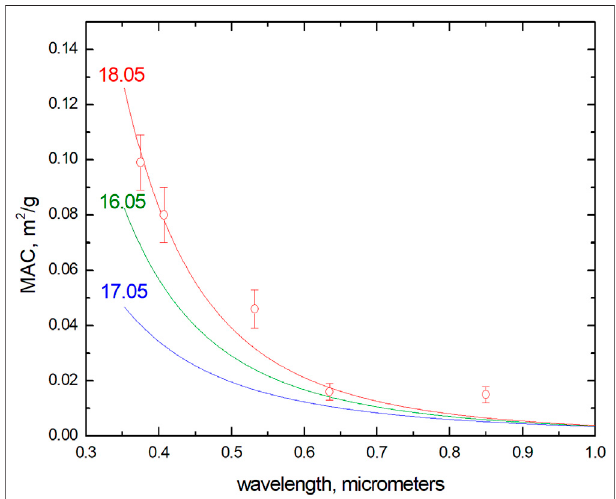
FIGURE 2 | The derived dust mass absorption coef fi cients for the three days. Symbols represent experimental measurement of the mass absorption coef fi cient in the CESAM simulation chamber (Caponi et al., 2017).